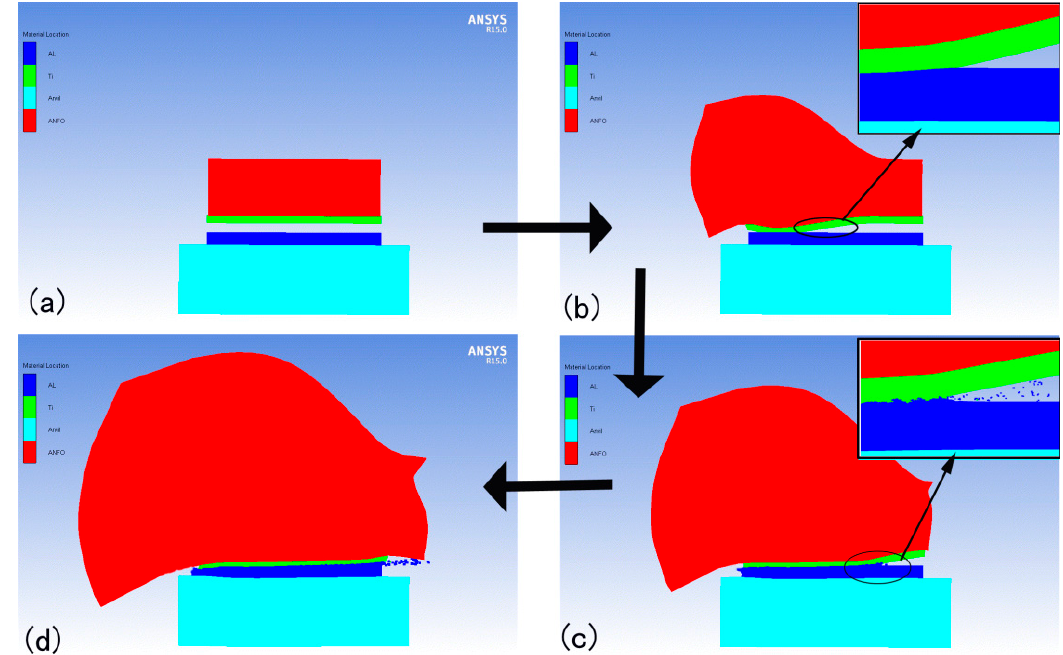
Figure 3. The explosive welding process in the simulation: ( a ) Before explosion; ( b ) initial explosion; ( c ) jet appearance; ( d ) welding completed.